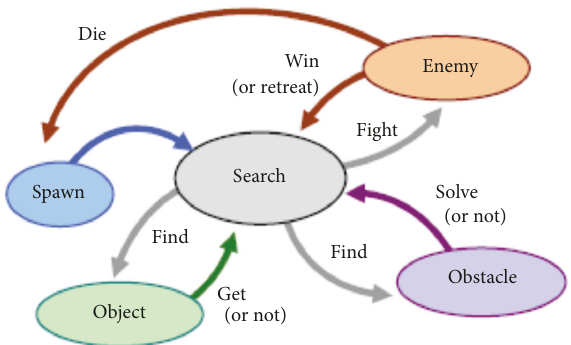
Figure 7: A simple FPS game state transition